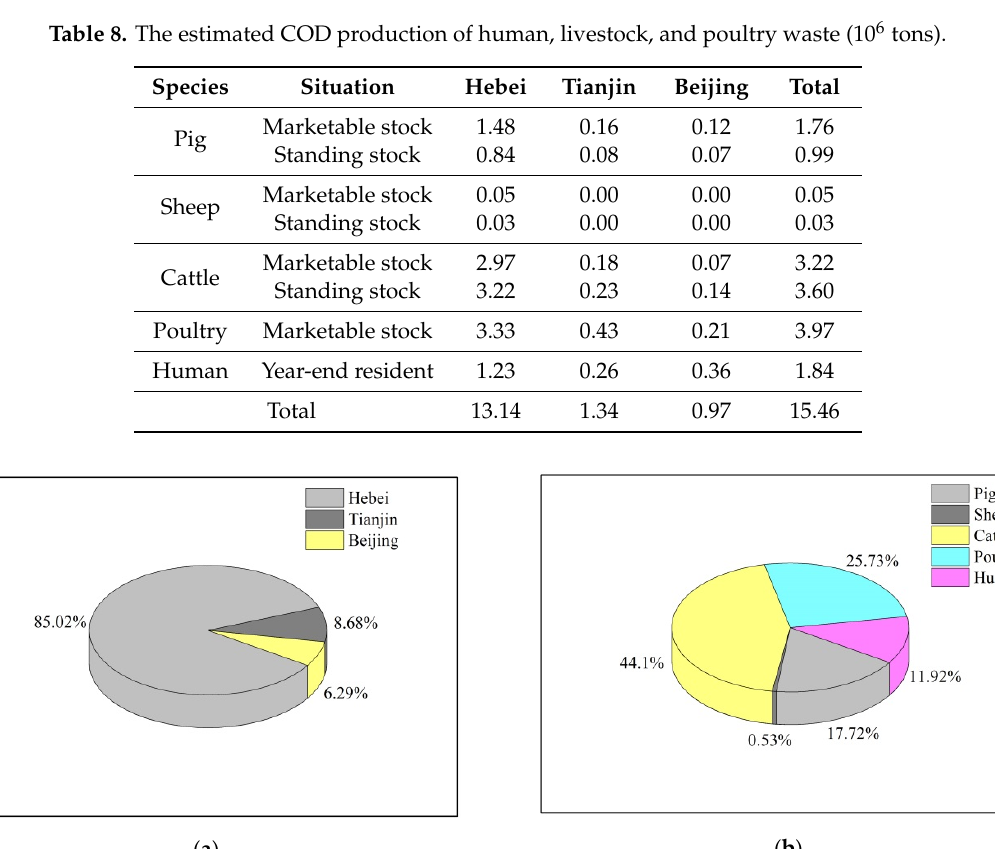
Table 7. The estimation of human, livestock, and poultry waste production (10 6 tons).